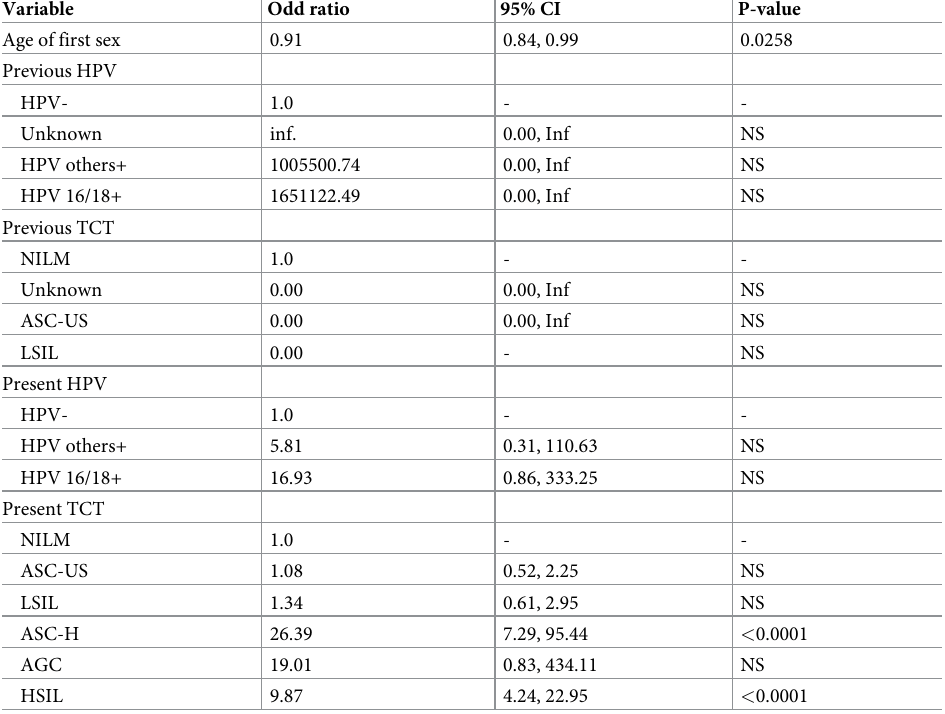
Table 3. Multivariate analysis of factor associated with